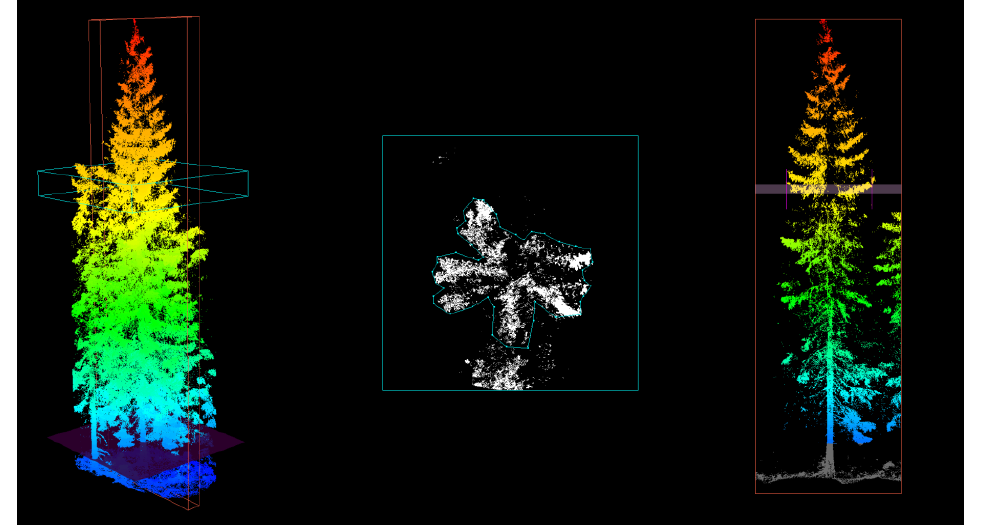
Figure 5. From the manual measurements in the TLS data: overview ( left ), crown area ( middle ) and crown width ( right ). The gradient colors are derived from the height of the laser echoes, and are added for visualization purposes.